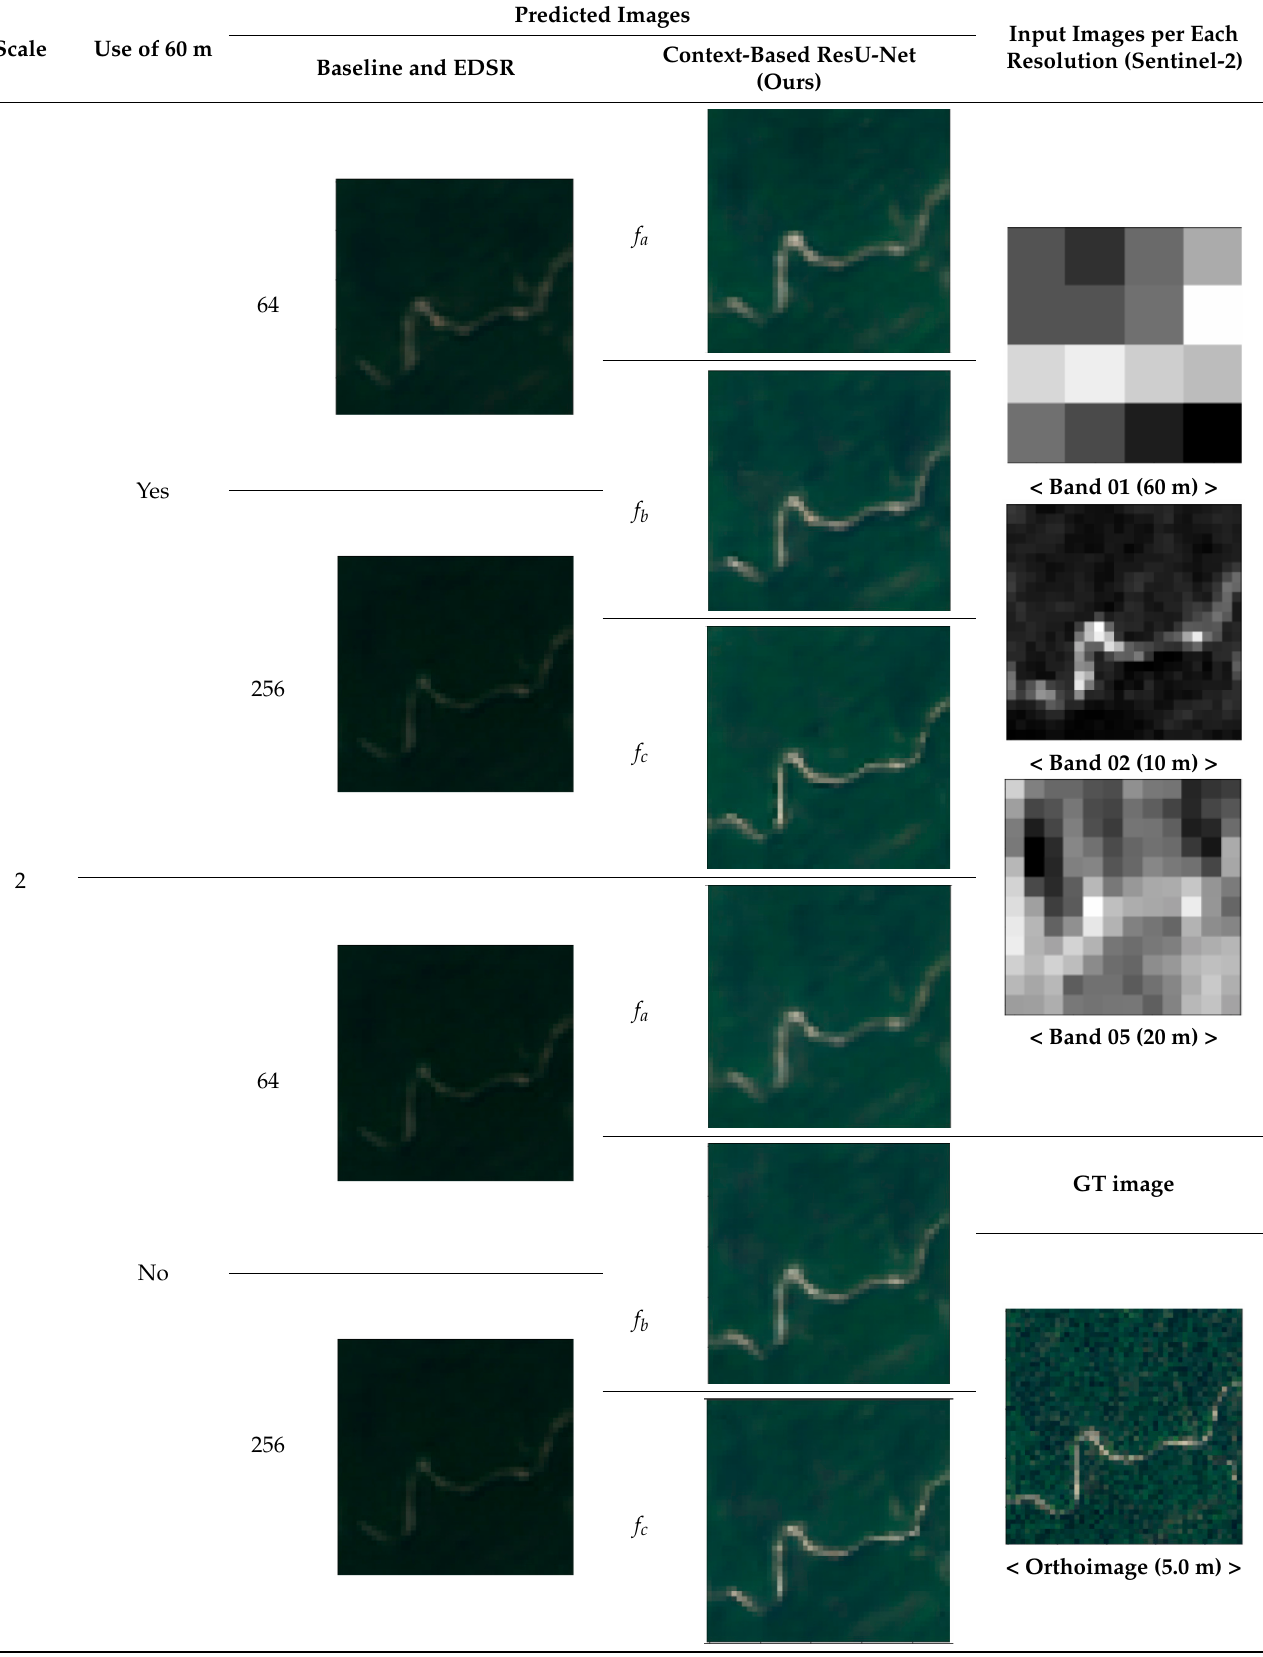
Table 7. Predicted images of Sentinel-2 and corresponding GT image (forest